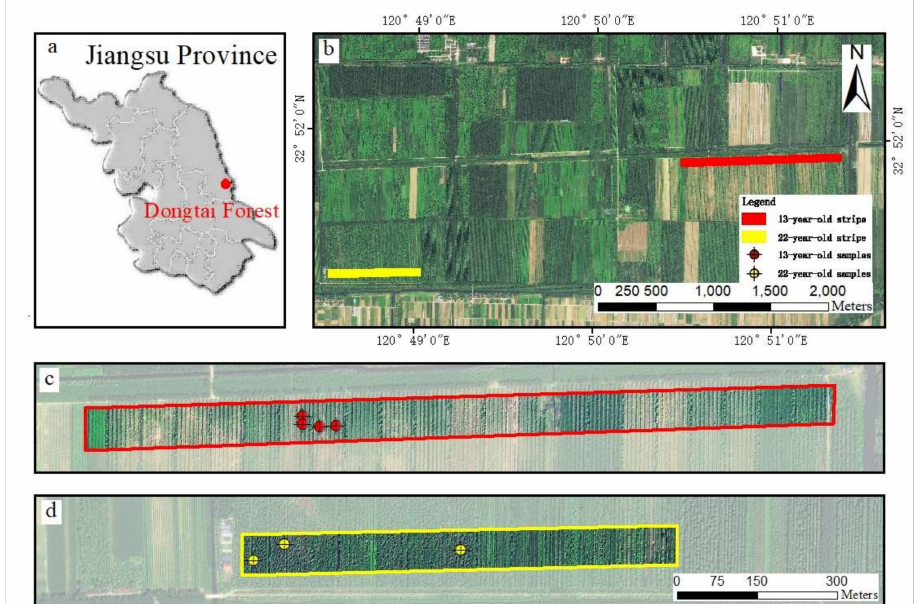
Figure 1. The location of UAV flight in the Dongtai Forest. ( a ): the Dongtai Forest study site in Jiangsu Province; ( b ): the locations of two UAV flight strips in the study site; ( c ): the 13-year-old stripe and No.1–4 sampling trees location; ( d ): the 22-year-old stripe and No.5–7 sampling trees